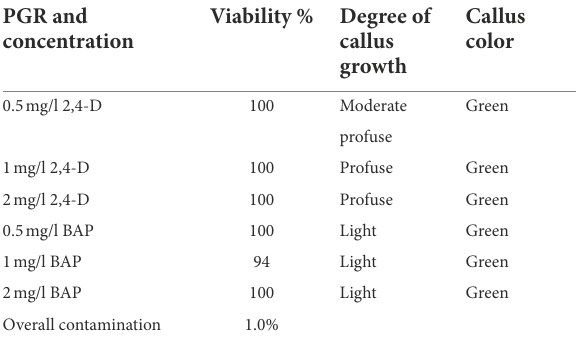
TABLE 3 Effectiveness of the surface sterilization method and H. tuberculatum immature seed explant response to 2,4-D and BAP different concentrations.